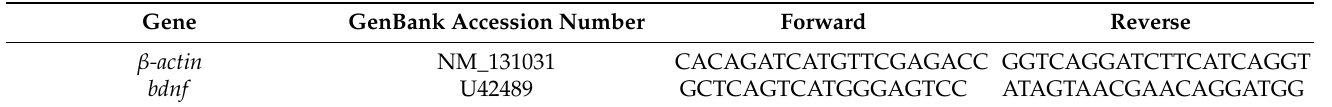
Table 2. Sequence (5 (cid:48) –3 (cid:48) ) of the